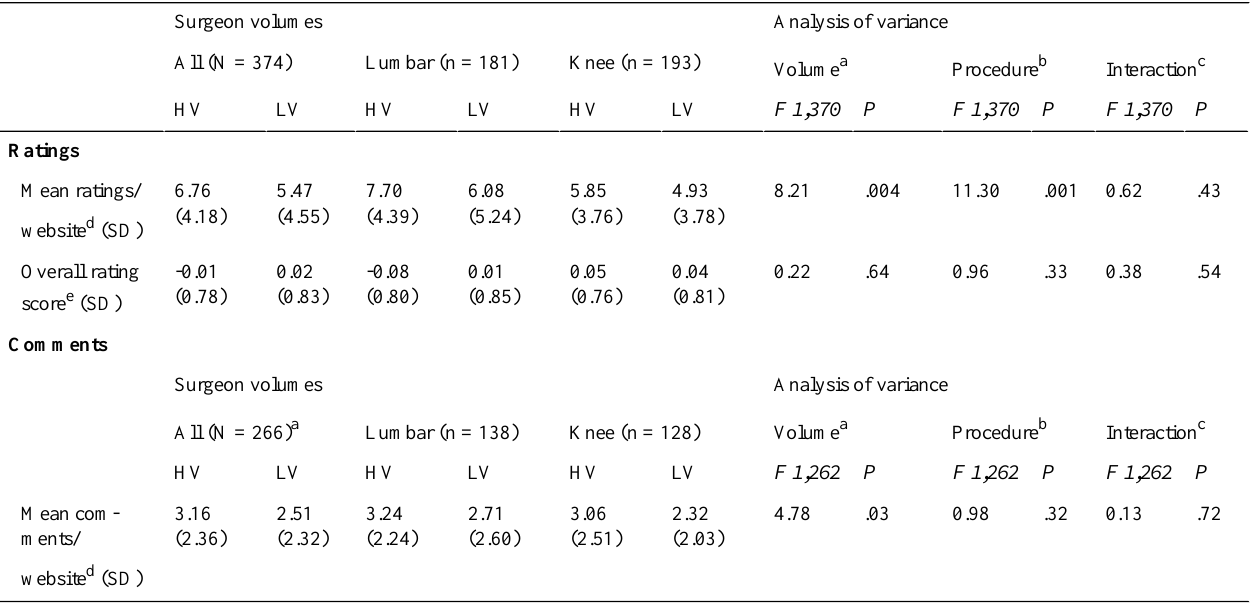
Table 8. Analysis of ratings and comments for high- and low-volume surgeons on first 20 websites (excluding bariatric surgery).